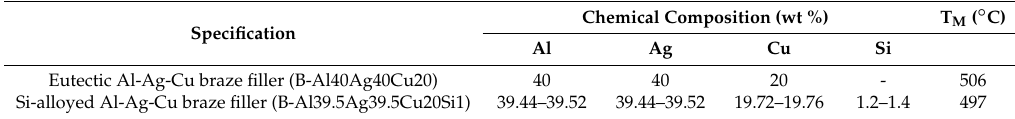
composition, Table 1. The homogeneity of alloying components within the produced braze filler rods is controlled and proven by EDXS analysis. Table 1. Chemical compositions and melting temperatures of the eutectic and Si-alloyed braze fillers.